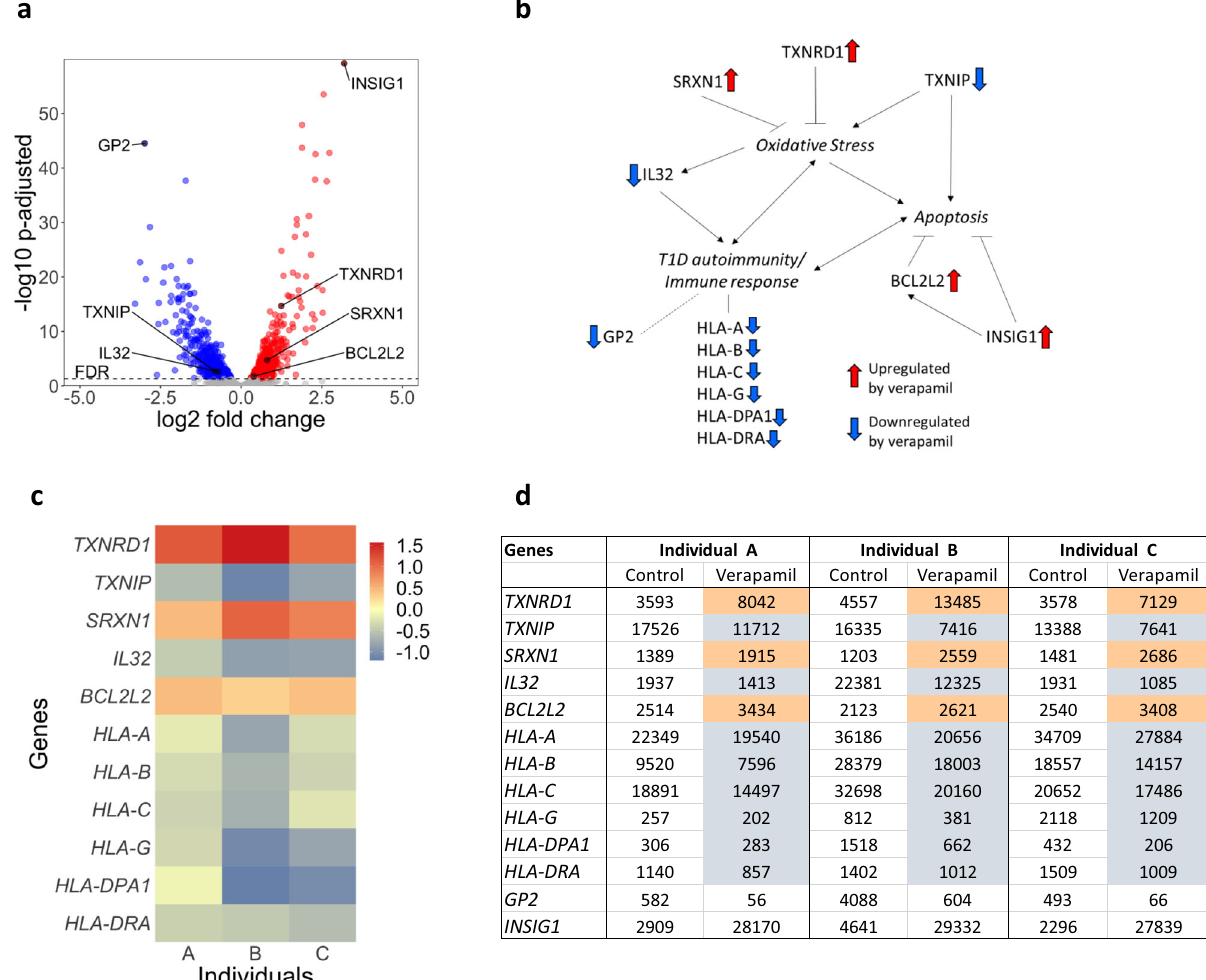
Fig. 4 Gene expression pro fi le changes in human islets in response to verapamil treatment. RNA sequencing was performed on isolated human islets from three different individuals (A – C) treated for 24 h with or without verapamil (100 µ M) with each donor serving as its own control. Volcano plot contains all genes with a baseMean expression of >500. Those genes with an adjusted DESeq2 P -value < 0.05 (calculated using a Wald test and the Benjamini – Hochberg method) are shown in blue (downregulated) and red (upregulated) ( a ). Key pathways modulated by differentially expressed genes ( b ). Heatmap showing key genes changed after treatment with verapamil (color scale represents log2 fold change) ( c ). Display of the normalized read counts for key genes before and after verapamil treatment of islets from each of the individual islet donors A – C ( d